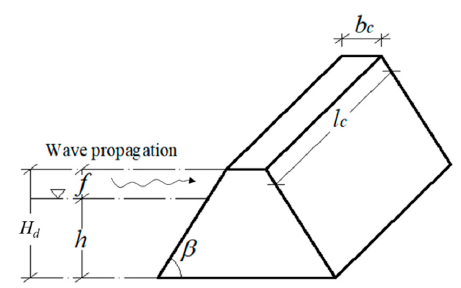
Figure 8. Definition sketch of a dam with the governing parameters.